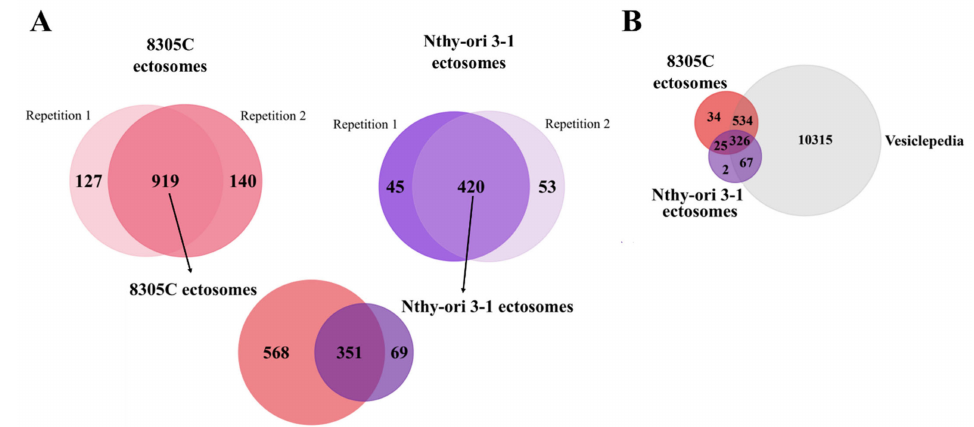
Figure 2. ( A ) Number of proteins identified in particular numbers of replicates of ectosome samples (the total number of six replicates included two biological replicates with three technical replicates each) and Venn diagram illustrating the number of proteins identified in two biological replicates of ectosomes derived from normal thyroid follicular epithelial Nthy-ori 3-1 cells and thyroid anaplastic carcinoma 8305C cells by at least two peptides. ( B ) Venn diagram illustrating protein overlap between isolated ectosomes with Vesiclepedia database as a reference.